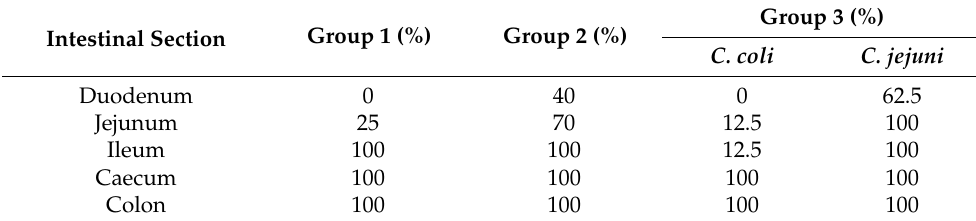
Table 5. Isolation frequency of Campylobacter spp. in different intestinal sections after dissection in the twelfth week of life. C. coli mono-infection in Group 1; C. jejuni mono-infection in Group 2; co-infection divided into detection of C. jejuni and C. coli (Group 1: n = 8; Group 2: n = 10; Group 3: n =